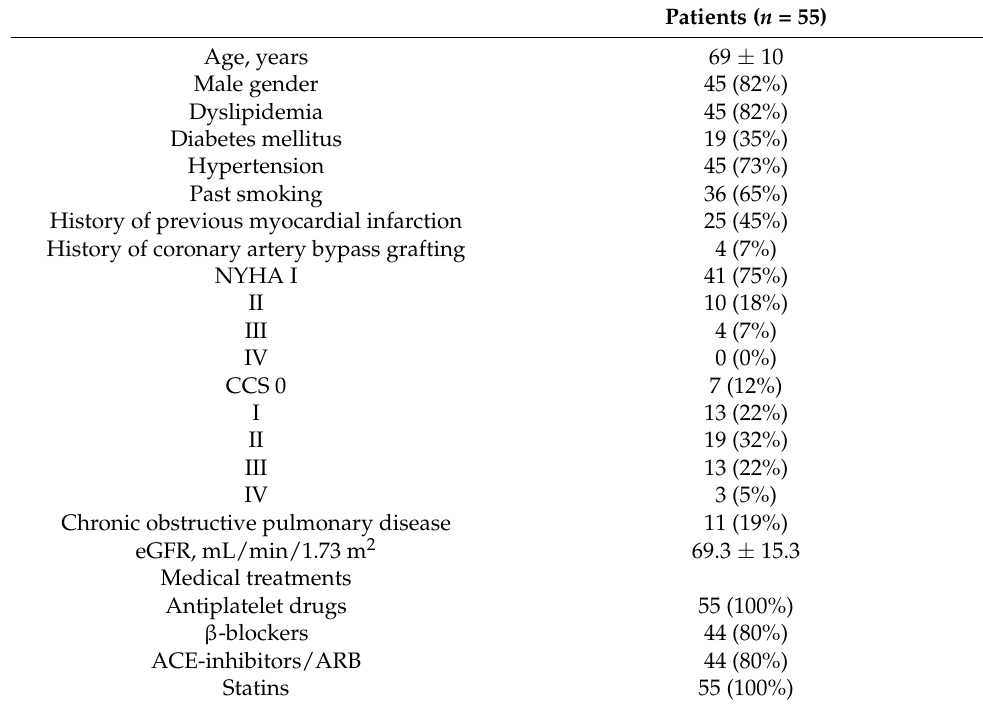
Table 1. Patient